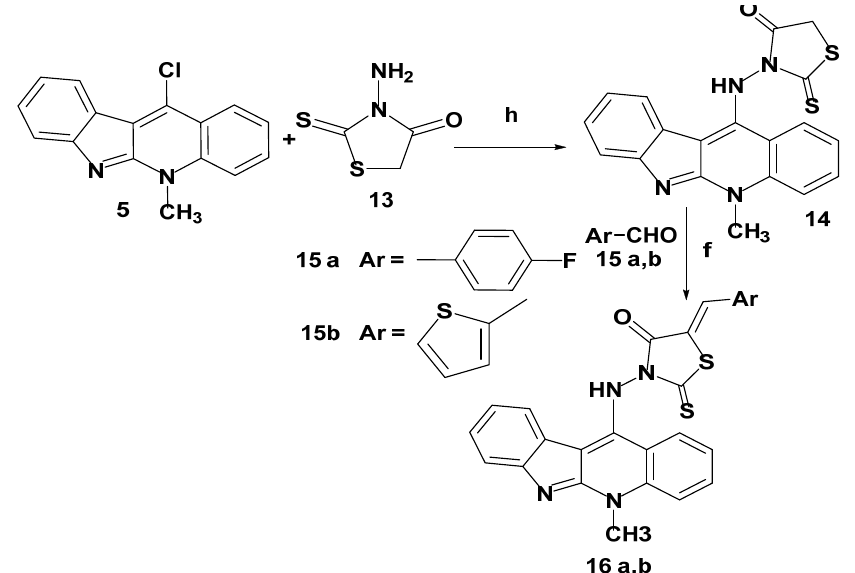
Scheme 10. Synthesis of neocryptolePine–rhodanine hybrids 16a , b . Reagents and conditions: